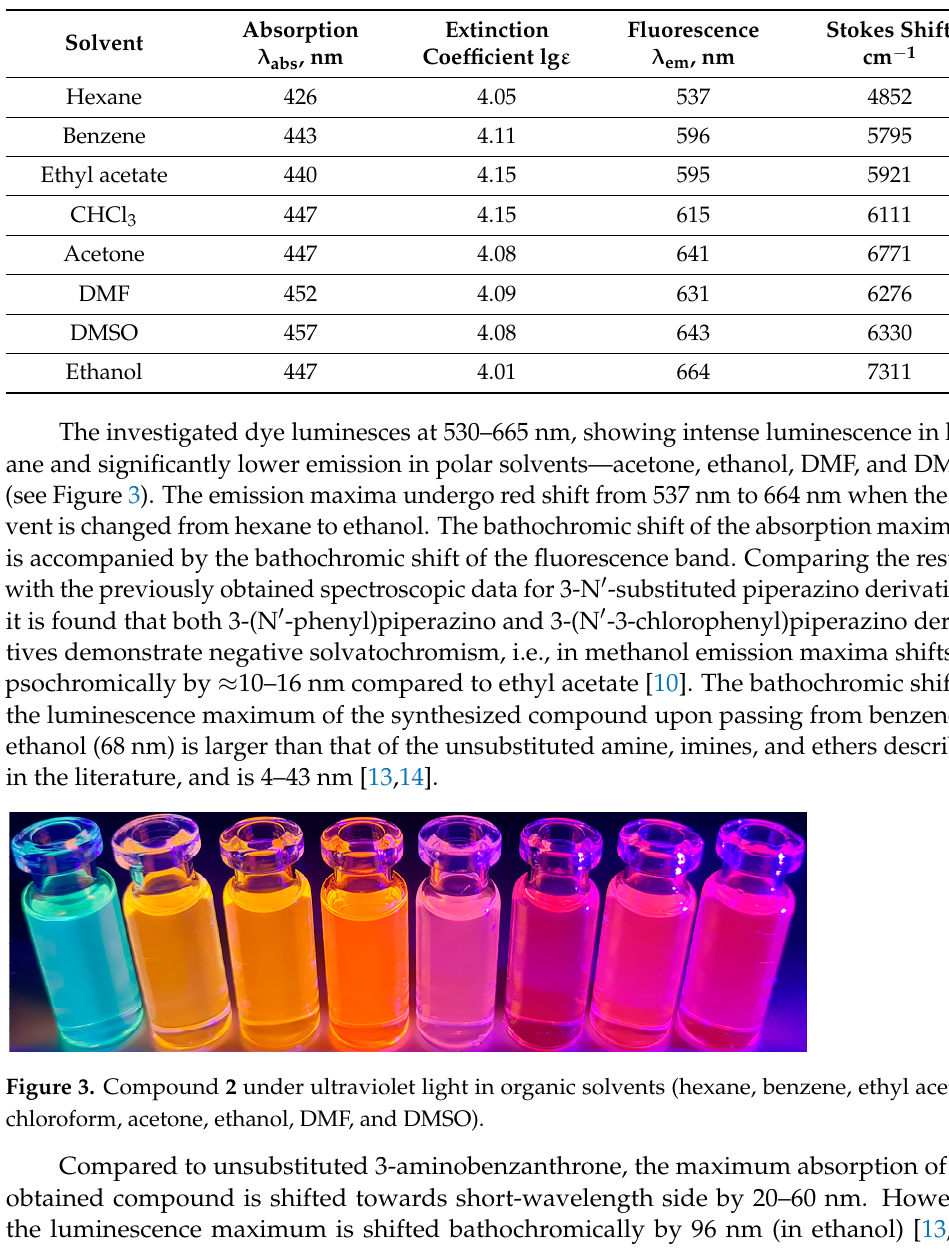
Table 2. Photophysical parameters of compound 2 in various solvents (concentration is 10 − 5 mol l − 1 ).